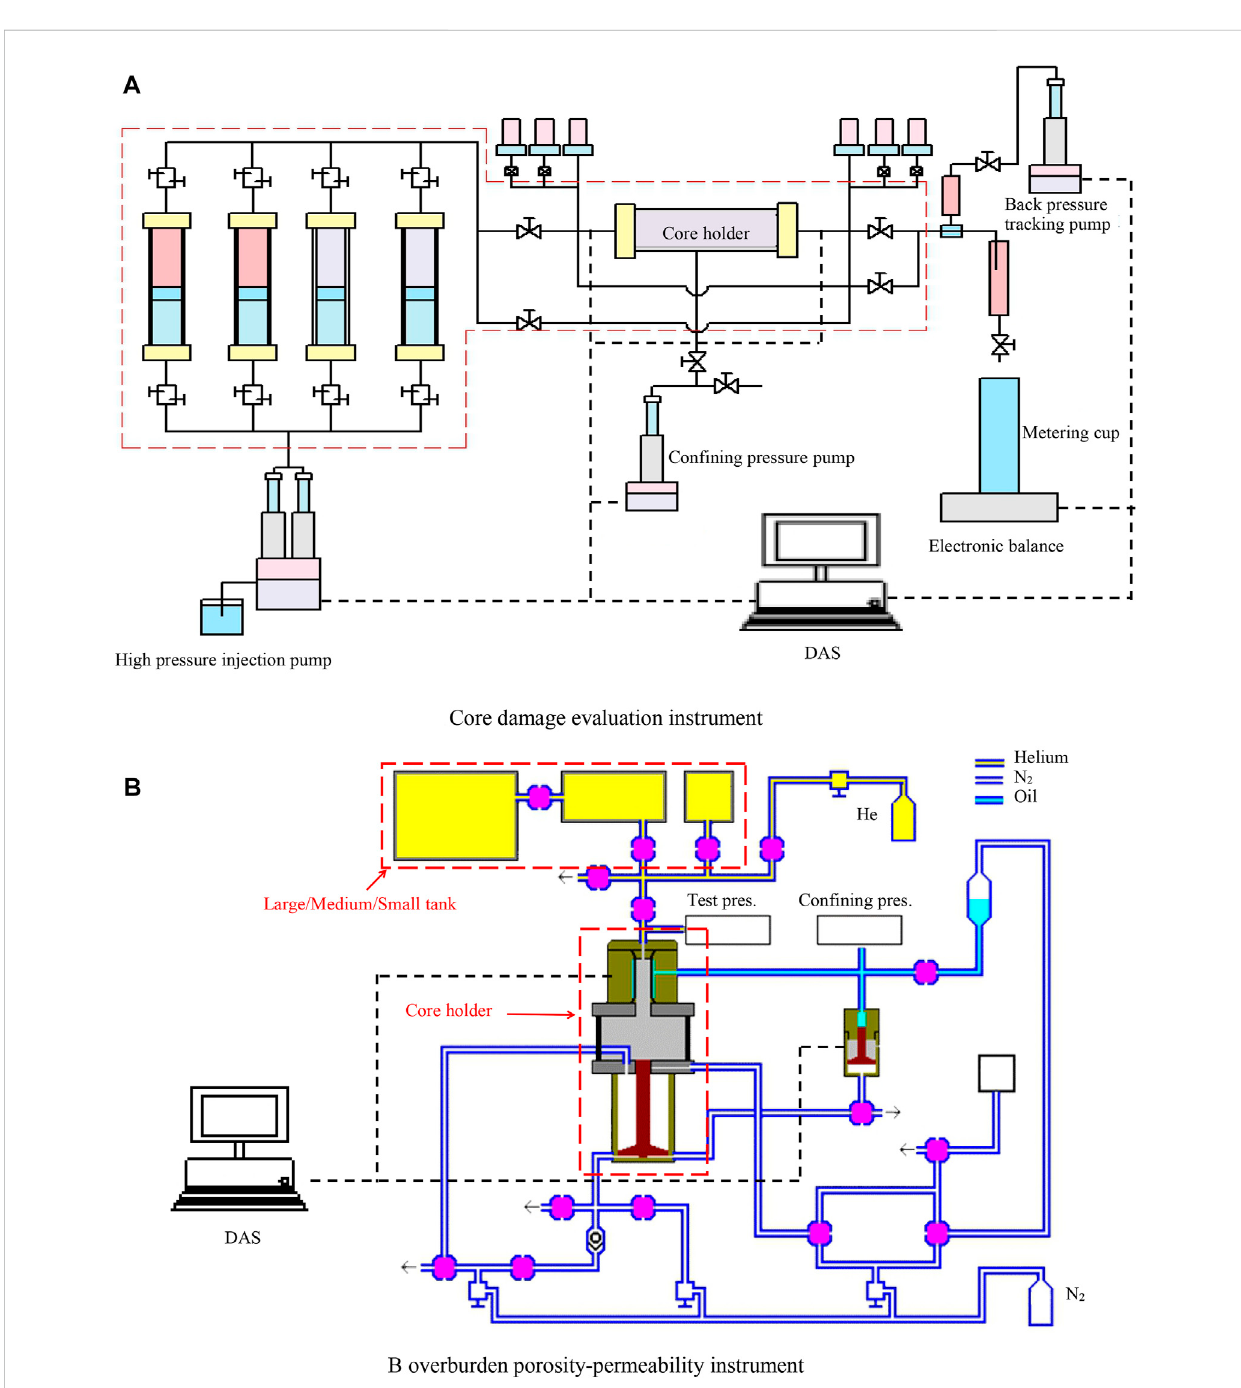
FIGURE 2 Flow chart of experimental equipments. (A) : Core damage evaluation instrument, (B) : overburden porosity-permeability instrument.